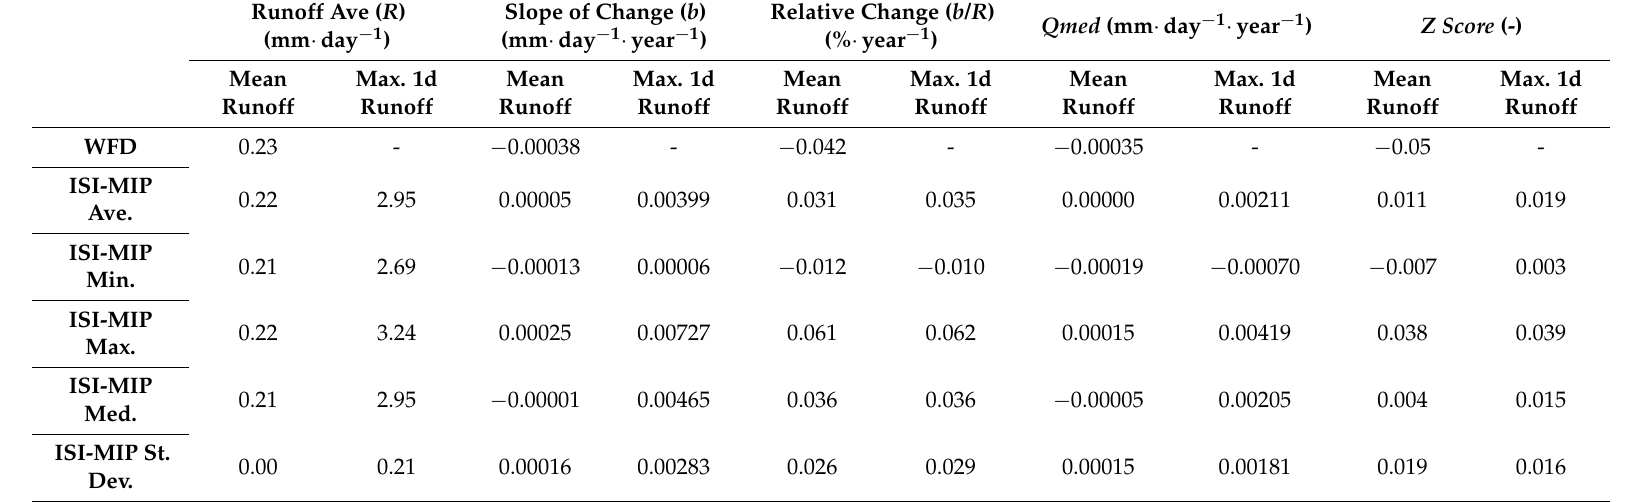
Table 3. Global-averaged results of mean and annual-maximum 1-day runoff trend analysis—WBM runoff simulations based on the WFD observation-based inputs as well as from the ISI-MIP (WBM model driven by GCM climate forcing), for 1971–2001. The 5 ISI-MIP models give 5 global averages, of which the minimum, maximum, median, mean, and standard deviation are presented. Ave. = Average, Min. = Minimum, Max. = Maximum, Med. = Median, St. Dev. = Standard